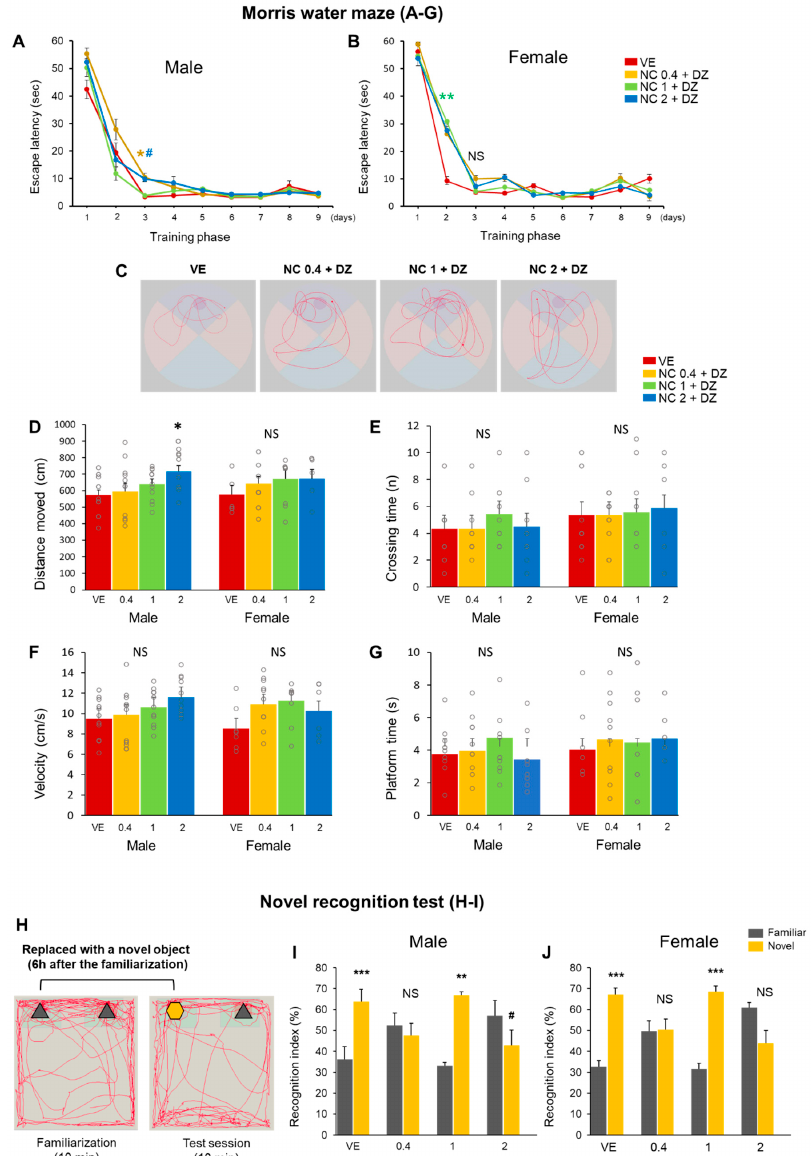
Figure 4. Combined exposure to nicotine and diazinon disrupted spatial reference learning and novel recognition behav- iors. ( A ), Morris water maze test for male offspring, NC0.4 + DZ and NC2 + DZ-treated group showed relatively greater delay for escape time during the initial phase of leaning compared to mice from the control group, (day 3: * p < 0.05 vs. NC0.1 + DZ vs. VE; # p < 0.05, NC2 + DZ vs. VE, F 3,64 = 6.197, p = 0.004); ( B ), Morris water maze test for female offspring,